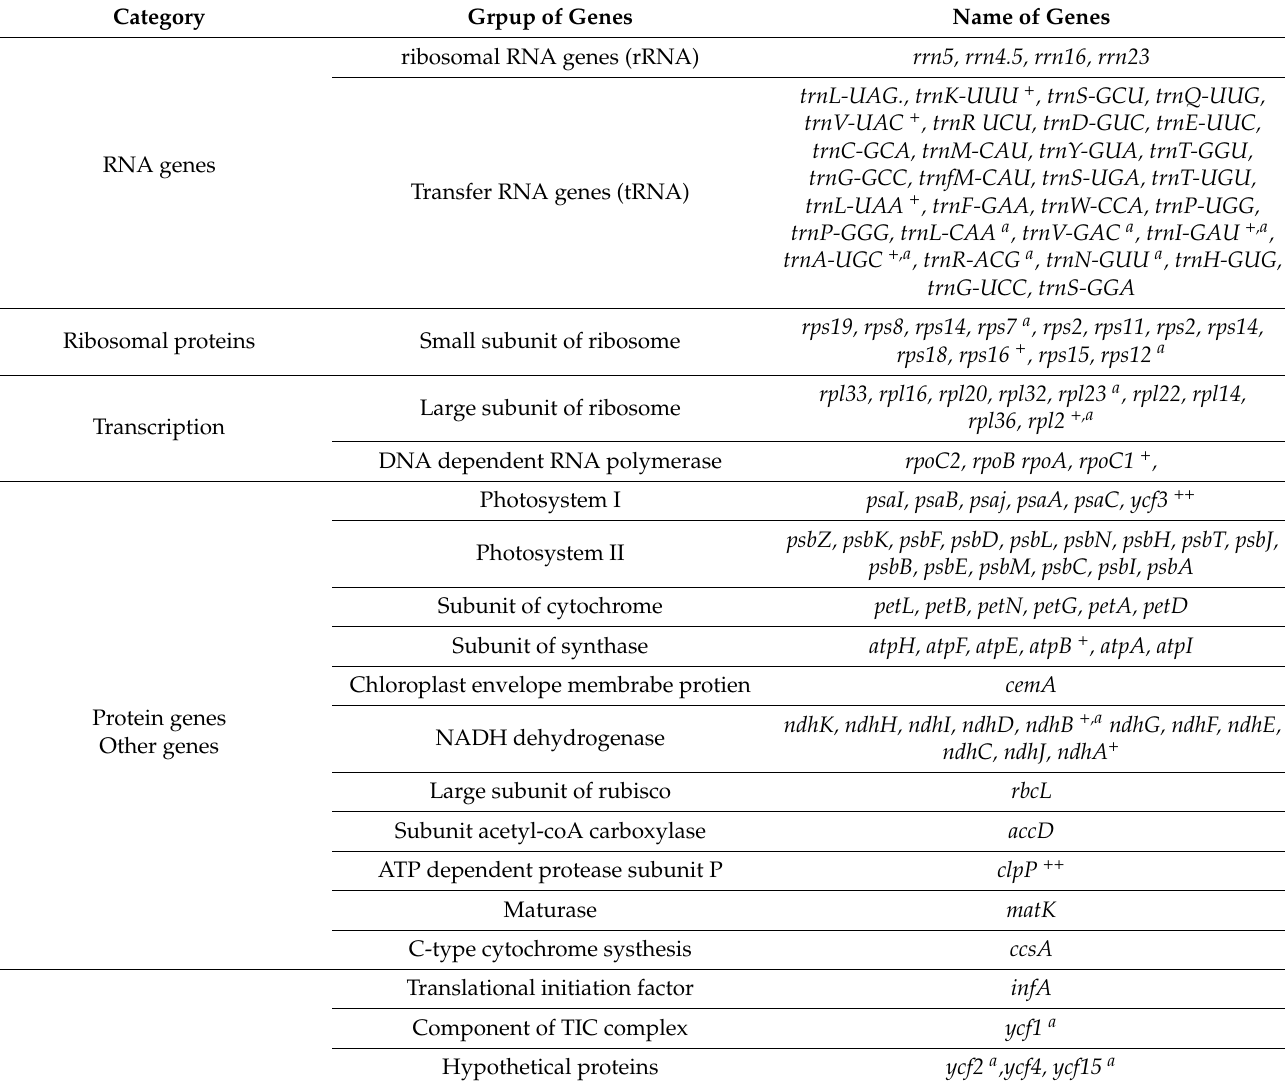
Table 2. Genes present in the chloroplast genome of H. forskaolii .